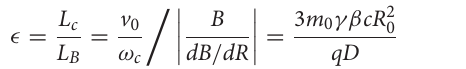
field lines approaching the Earth. For a relativistic electron, the drift velocity due to curvature and